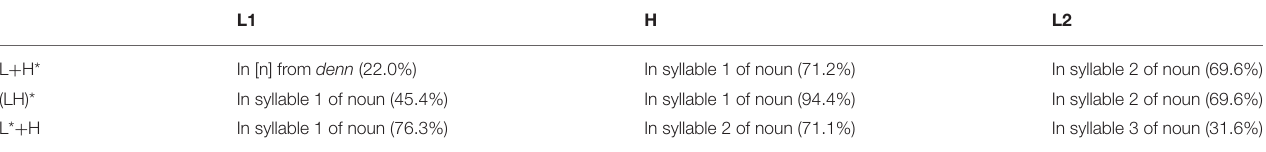
TABLE 1 | Alignment of tonal targets (L1, H, L2) in rising-falling contours in experimental stimuli; L + H * and L * + H values based on natural recordings, (LH) * values based on Braun et al. (2019).